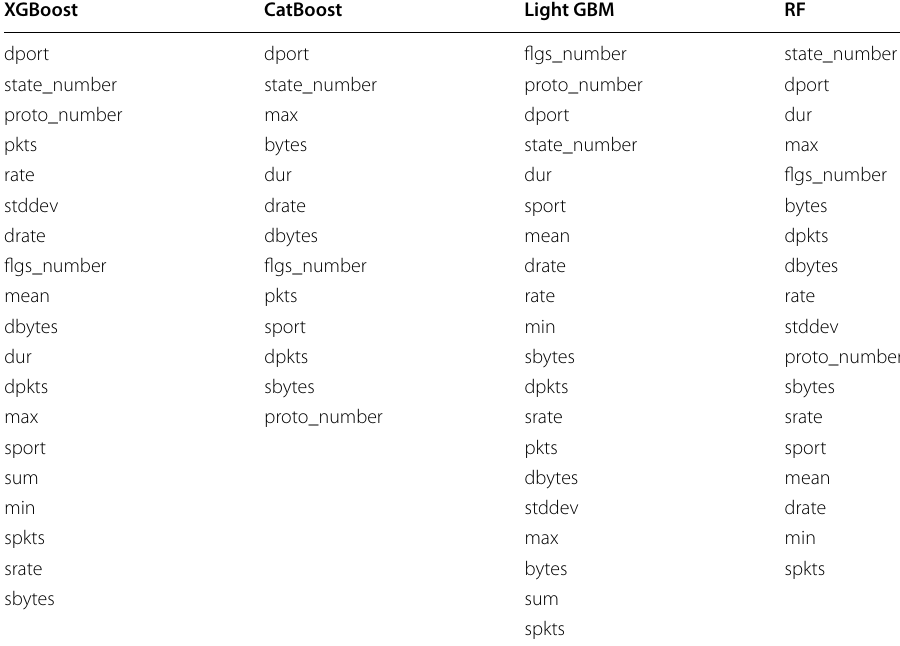
Table 47 Features by supervised ranking feature importance